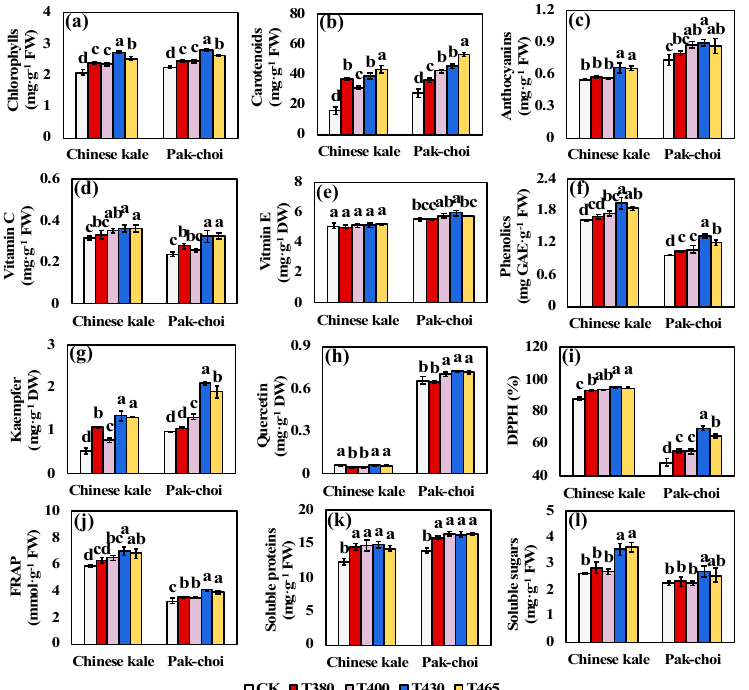
Figure 2. Phytochemical profiles of two baby-leaves under di ff erent wavebands of blue and UV-A light. The contents of ( a–c ) pigments, ( d – h ) antioxidant compounds and ( k – l ) nutritional compounds. ( i – j ) were the antioxidant activities. DPPH = 2,2-diphenyl-1-picrylhydrazyl radical scavenging, FRAP = ferric reducing antioxidant power. Di ff erent letters (a–e) upon the bar plots indicate significant di ff erence at p < 0.05 using one-way analysis of variance with Duncan’s multiple-range